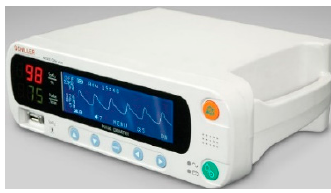
Figure 21. Schiller Argus OXM plus reference device.